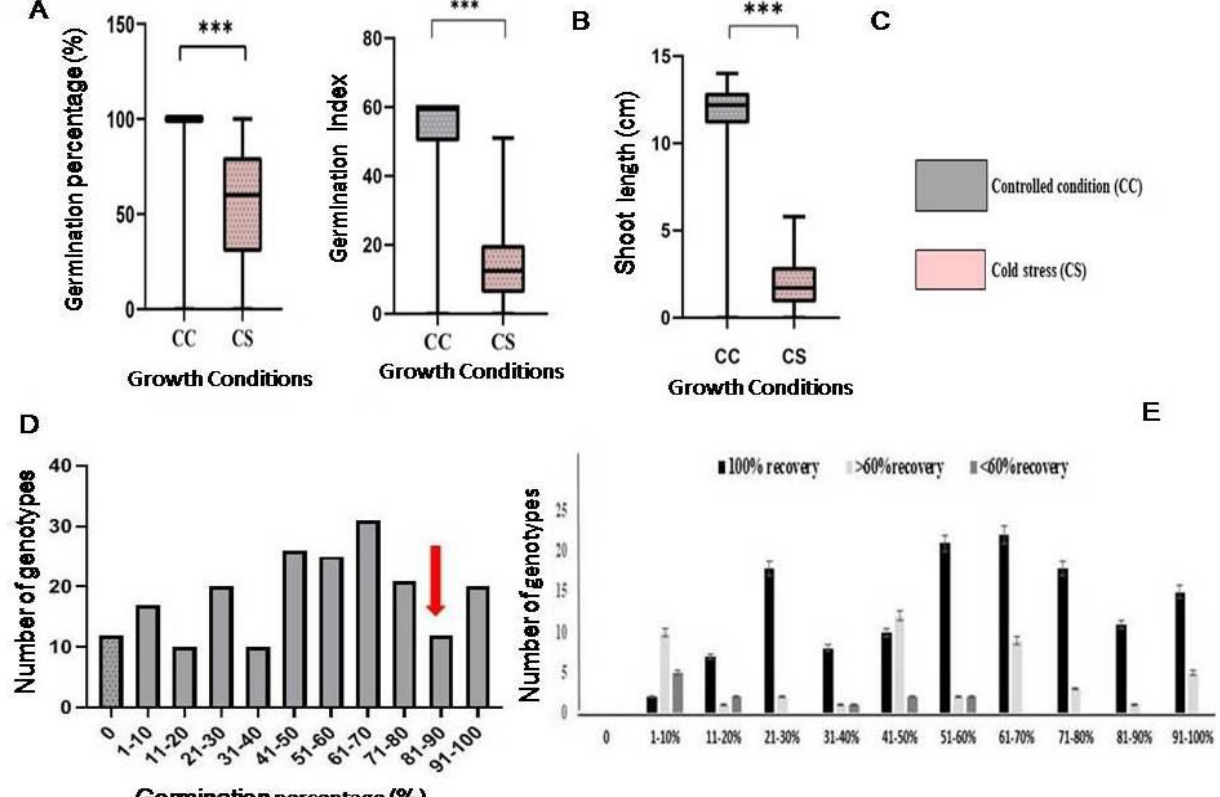
Figure 1. Germination percentage and recovery of V. radiata genotypes. Notably, 204 V. radiata genotypes were phenotyped for germination % at 10 ◦ C on 8th day after sowing (DAS). ( A ) Germination %, ( B ) Germination Index, ( C ) seedling shoot length at 22 ◦ C (control, CC) or 10 ◦ C (Cold stress, CS), ( D ) germination % of population categorized into intervals of 10% each. RED arrow indicates well known high yielding genotype IPM-02-14. Colored arrows indicate the germination % of G88, G77 and G92, mentioned in the Section 3.6 of the text. ( E ) This figure shows genotypes with 100%, >60% and <60% recovery rate. Recovery was assayed by keeping the plants for recovery at 22 ◦ C for 7 more days under CC after 8 days CS. Recovery % was calculated from the ratio of number of plants that survived to the total number of plants after CS.RED arrow indicates recovery of genotype IPM-02-14. Significance was conducted using unpaired t -test and is indicated as ***, which indicates p < 0.005.